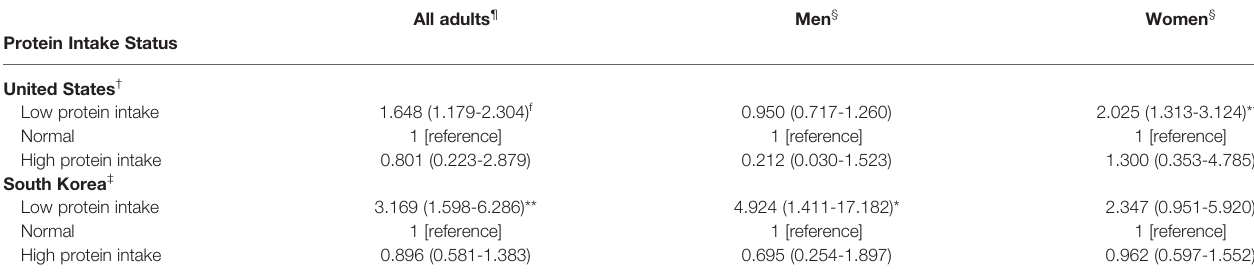
TABLE 4 | Adjusted association between protein groups and depression in United States and South Korea.